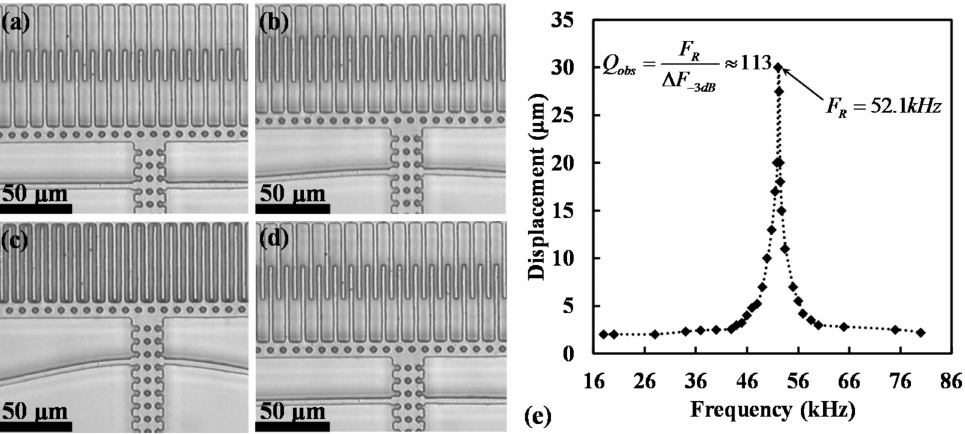
Figure 10. Frequency response through stroboscopic freeze frame images of comb drive actuator at maximum displacements for different frequencies ( a ) No actuation, ( b ) 50 kHz, ( c ) 52.1 kHz, ( d ) 80 kHz and ( e ) Frequency response graph for all of the frequencies tested giving observed Q factor ≈ 113 and resonance frequency of 52.1 kHz.